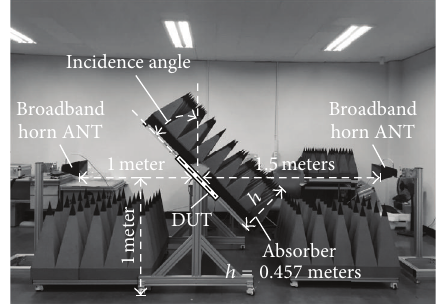
Figure 4: Free space measurement setup for the proposed